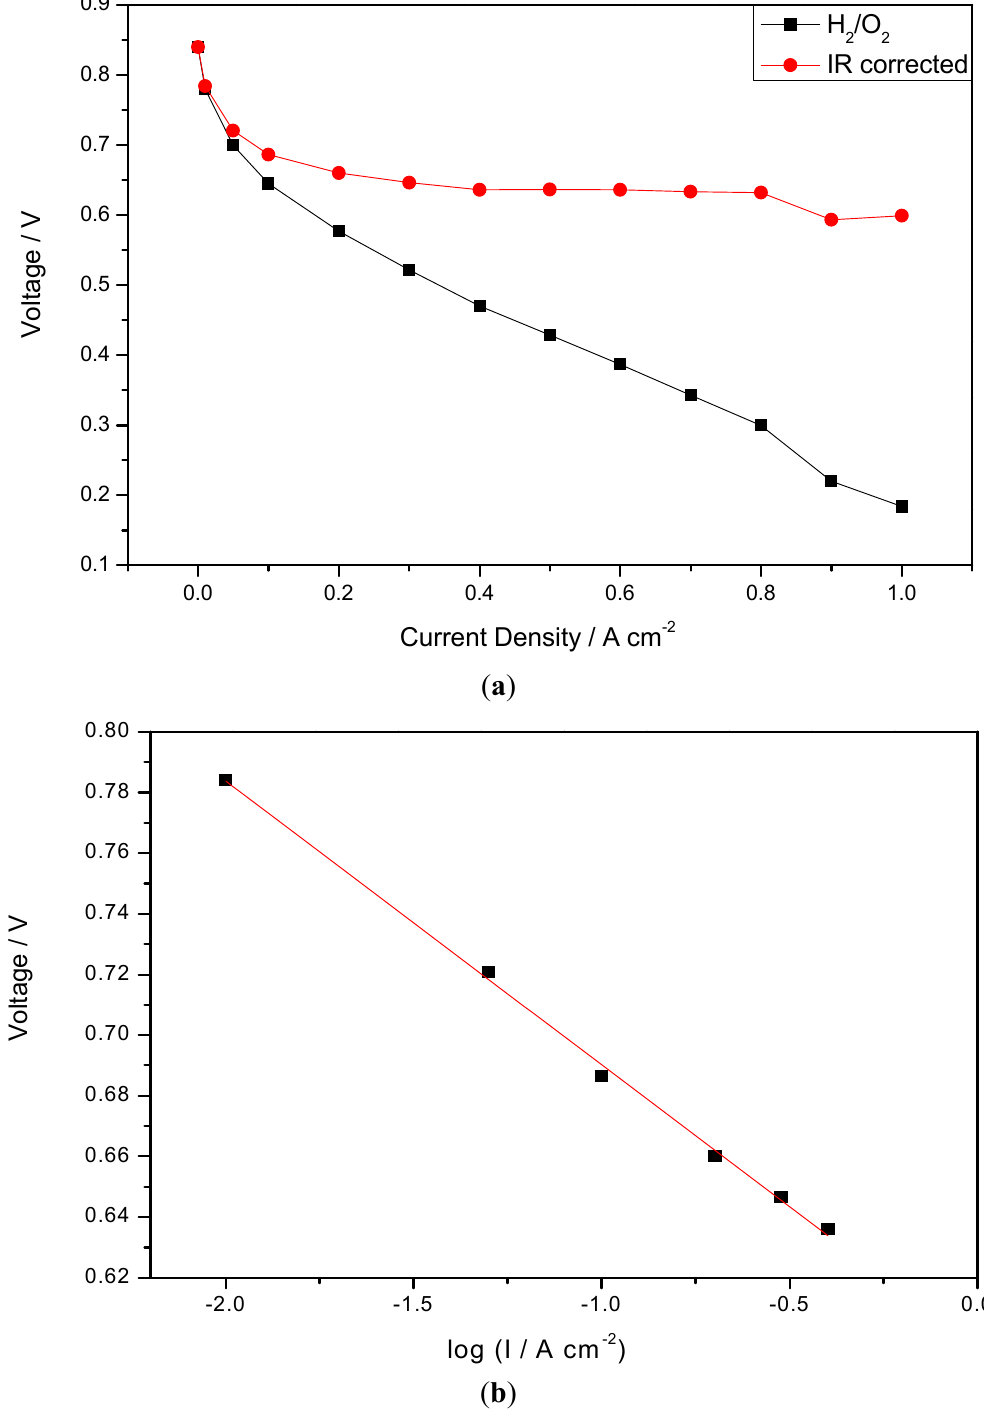
Figure 7. ( a ) IR corrected polarization curves of CsPOMo/PSU/PTFE; ( b ) Tafel plots obtained from polarization curves (I is current